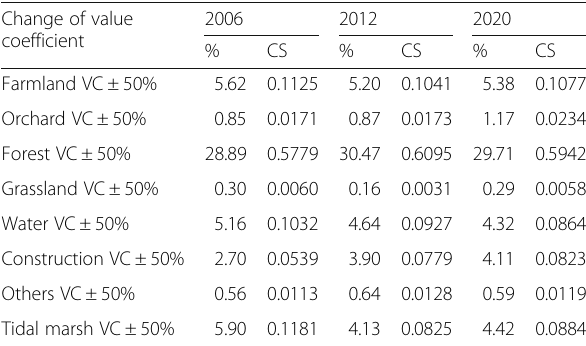
Table 9 Percentage changes in estimated ESV and CS resulting from a 50% adjustment in VC